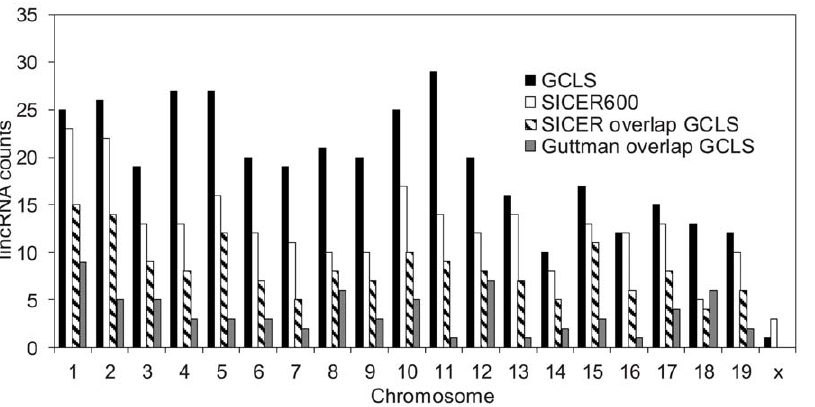
Figure 3. Comparison of the lincRNA overlap among three different methods: GCLS, SICER600 and Guttman’s method in [ 3 ] . The counts of lincRNAs are grouped in the ascending order of chromosomes.